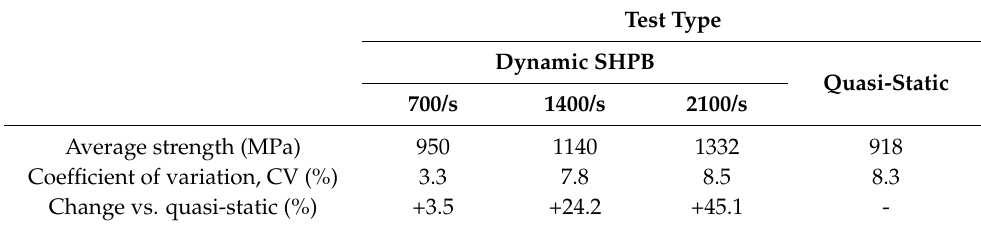
Figure 12. Quasi-static tensile strength of T700/PA6.6 versus dynamic tensile strengths (normal- ized to the quasi-static tensile strength).